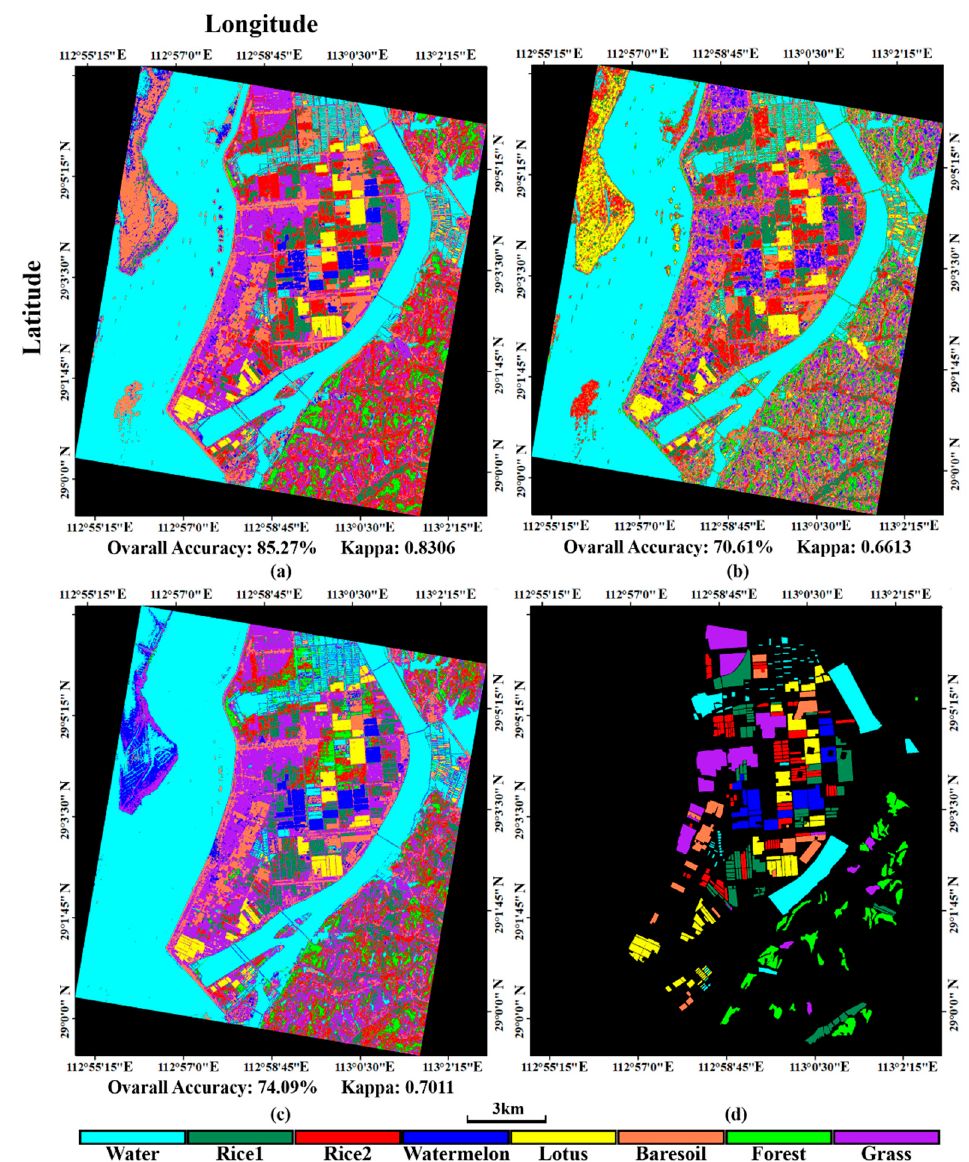
Figure 6. The classification results generated from ( a ) the integrated data ( b ) the GF-3 data and ( c ) the Sentinel-2A data; ( d ) the testing sample.